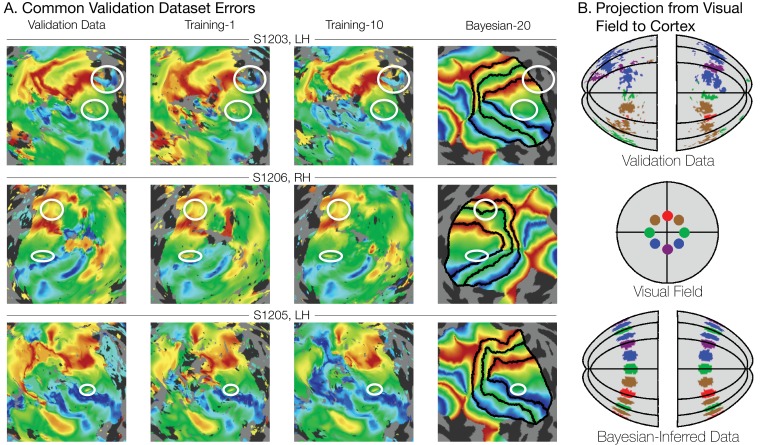
Systematic errors in training and validation datasets.(A) Many small inconsistencies in the retinotopic maps are duplicated in both the validation dataset and the training datasets but not in the maps predicted by Bayesian inference. Maps for three example hemispheres are shown with validation datasets as well as training dataset 1, training dataset 10, and the Bayesian-inferred maps from dataset 20. Ellipses highlight blips of noise in the validation maps that are unlikely to represent the true underlying map, but that are correlated with the training maps. Such blips are significantly different in the inferred and validation maps, likely inflating the error of the inferred maps. Black lines show the V1-V3 boundaries in the Bayesian-inferred maps. (B) Discontinuity errors. If the validation data is used to project the disks shown in the visual field in the middle panel to the cortical surface, the resulting map is messy and contains a number of inconsistencies due to measurement error. While the Bayesian inferred map may contain errors of its own, it will always predict a topologically smooth retinotopic map with respect to the topology of the visual field.